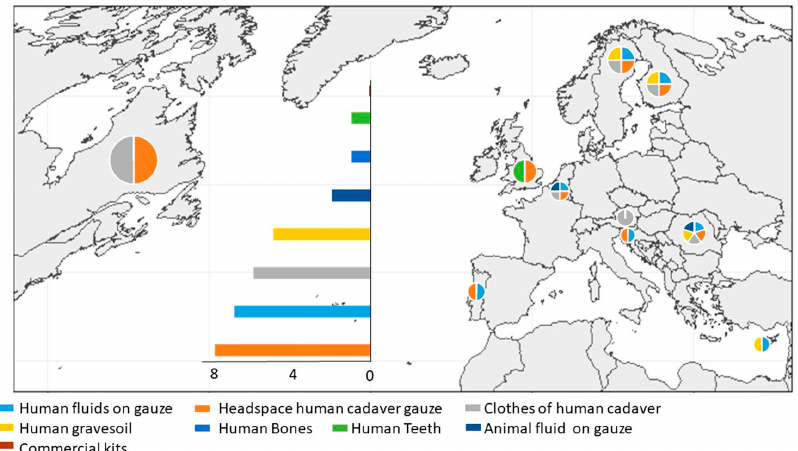
Figure 5. Types of training aids used by the surveyed human remains detection dogs’ brigades to train their dogs. Colors in the pie charts represent the diversity of training aids used by the teams in the country where the chart is located. The bar chart represents the number of human remains detection dogs’ teams (y axe) which use the different training aids.